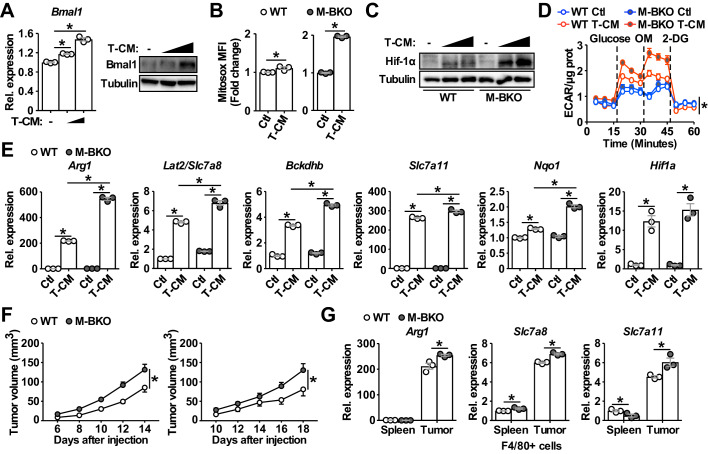
Bmal1 regulates tumor-associated macrophage polarization.(A) Bmal1 gene expression (left panel) and protein levels (right panel) in WT macrophages treated with control medium or increasing doses of B16-F10 tumor-conditioned medium (T-CM, diluted 1:3 or 1:1 with control medium) for 8 hr. N = 3 biological replicates for qPCR, statistical analysis was performed using Student’s T test. (B) Measurement of mROS using MitoSox Red (mean fluorescent intensity, MFI) in mitochondria from macrophages treated with control medium or T-CM diluted 1:1 with control medium for 1 hr. N = 3 biological replicates, statistical analysis was performed using Student’s T test. (C) Hif-1α protein levels in WT and M-BKO macrophages treated with control medium, T-CM diluted 1:1 with control medium, or undiluted T-CM for 4 hr. (D) Glycolytic stress test in macrophages pretreated with control medium or T-CM diluted 1:1 with control medium for 4 hr. N = 5 biological replicates. Statistical analysis was performed using two-way ANOVA comparing T-CM-treated M-BKO with WT cells across the time course. (E) Relative expression of genes involved in amino-acid metabolism and oxidative stress response in macrophages treated with control medium or T-CM diluted 1:3 with control medium for 8 hr, as determined by qPCR. N = 3 biological replicates, statistical analysis was performed using Student’s T test. (F) Tumor volume in male (left) and female (right) WT and M-BKO mice. 300,000 B16-F10 cells were injected subcutaneously into the right flank. N = 18 (male) and 8 (female) mice, statistical analysis was performed using two-way ANOVA for WT vs M-BKO mice across the time course. (G) Gene expression for F4/80+ cells isolated from B16-F10 tumors or spleens of female mice 14 days after injection. Tissues from six mice per genotype were pooled into three groups for leukocyte isolation. Statistical analysis was performed using Student’s T test. Data are presented as mean ± S.E.M. *, p<0.05. Experiments were repeated at least twice.